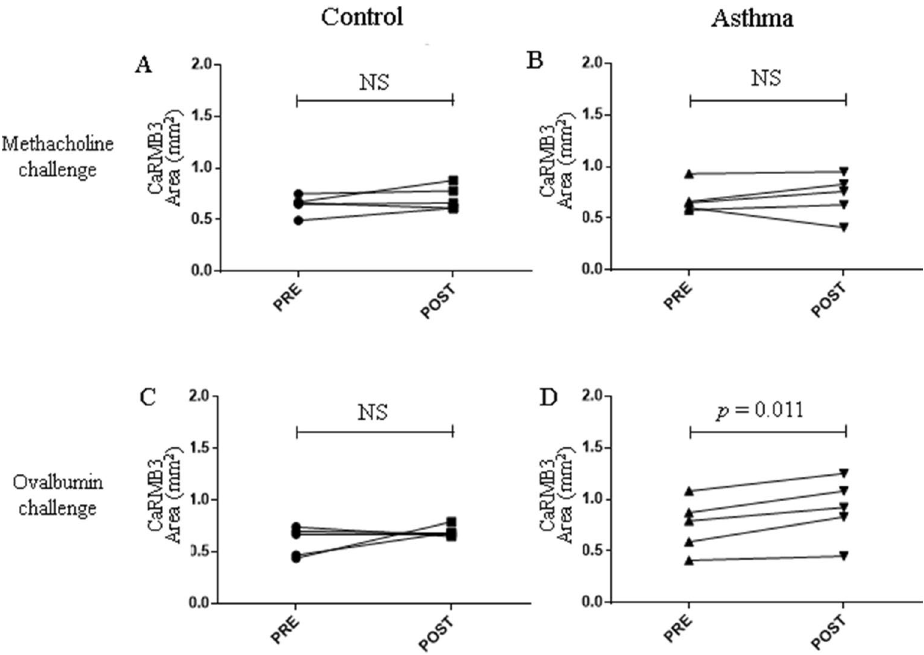
Figure 2. Airway changes during early phase reaction after methacholine and OVA challenge. (A) CaRMB3 change after methacholine challenge in control group, (B) CaRMB3 change after methacholine challenge in asthma group, (C) CaRMB3 change after OVA challenge in control group. (D) CaRMB3 change after OVA challenge in asthma group. In the control group, there was no change after methacholine or OVA challenge. The asthma group mice showed no significant change of airways to methacholine challenge. However, they showed slight but significant increase of airways to OVA